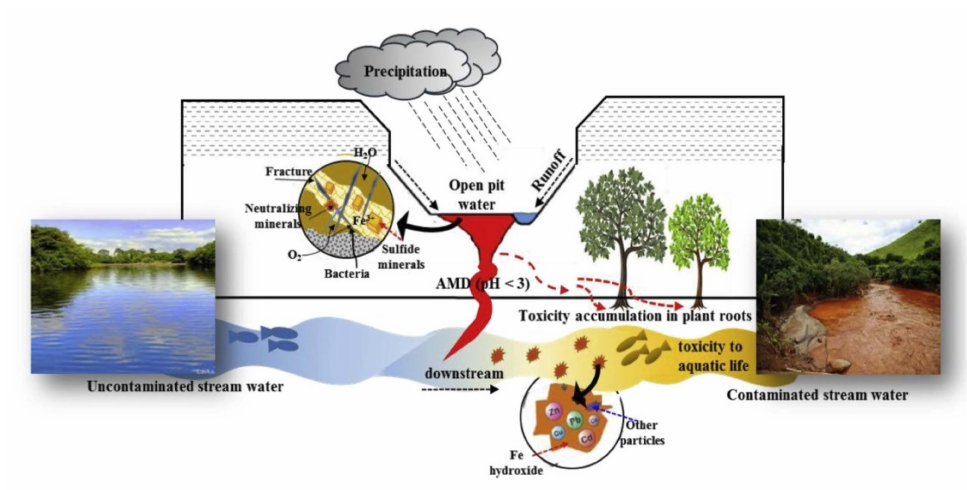
Figure 1. AMD formation and the corresponding contamination pathways. Adapted with permission from [26], copyrighter Elsevier, year 2019.